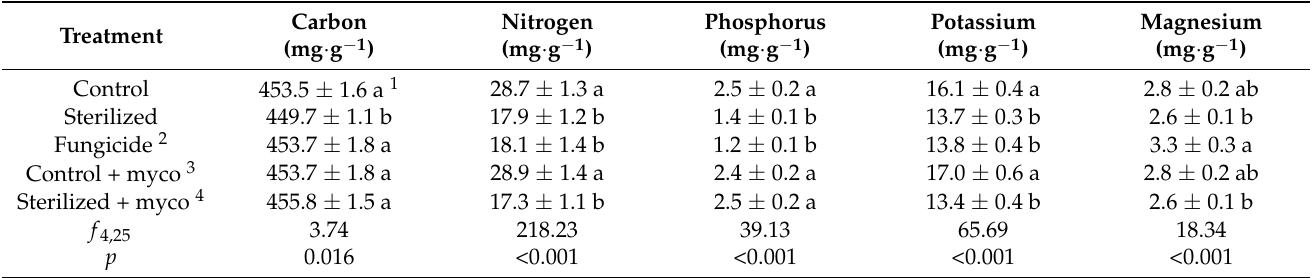
Table 10. The influence of growing Serianthes grandiflora plants in soil obtained from Serianthes grandiflora rhizosphere on leaf macronutrient content. Mean ± SE, n = 6.